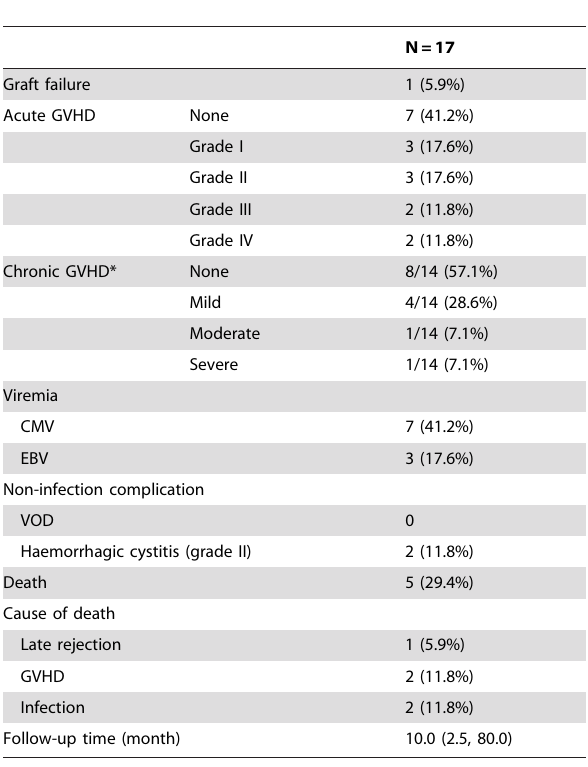
Table 2. Graft, acute GVHD, chronic GVHD, infection of virus and causes of death after haploidentical